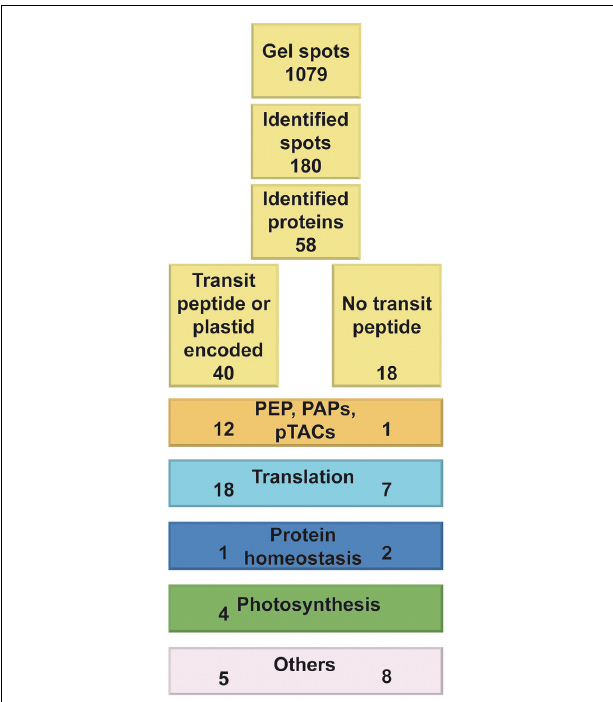
FIGURE 2 | Numbers of total, analyzed, and identified spots of the PC peak fractions. Proteins separated in the 2D gels shown in Figure 1C are given in yellow boxes at the top. Protein groups corresponding to Table 1 are displayed below in colored boxes. At the left side of each box the number of putative plastid proteins per bin being either plastid encoded or for which a plastid transit peptide was predicted is given. At the right side proteins without these properties are given.